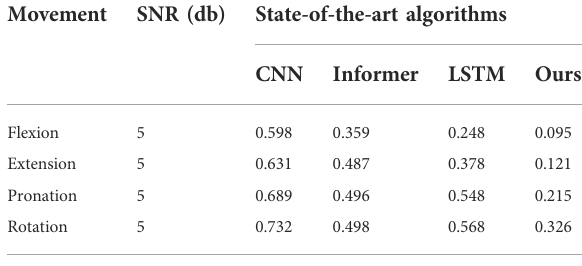
TABLE5MSEcomparisonwith5 dbnoiseamongdifferentalgorithms.